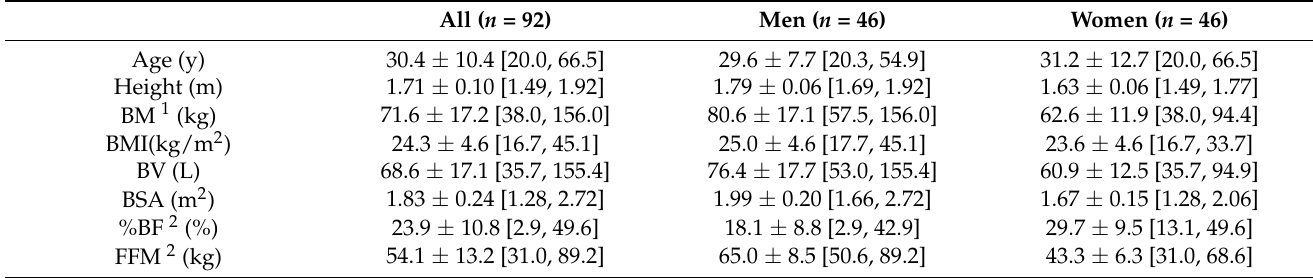
Table 1. Subject characteristics, reported as mean ± SD and range of values [min.,